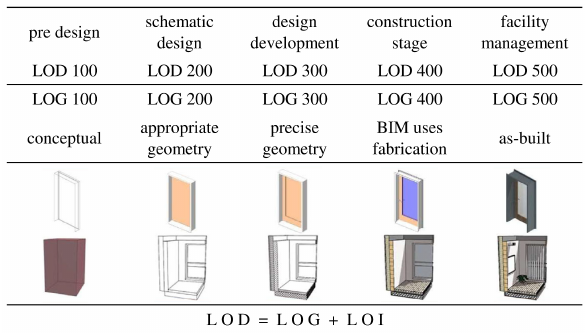
Figure 1 . LOD and LOG